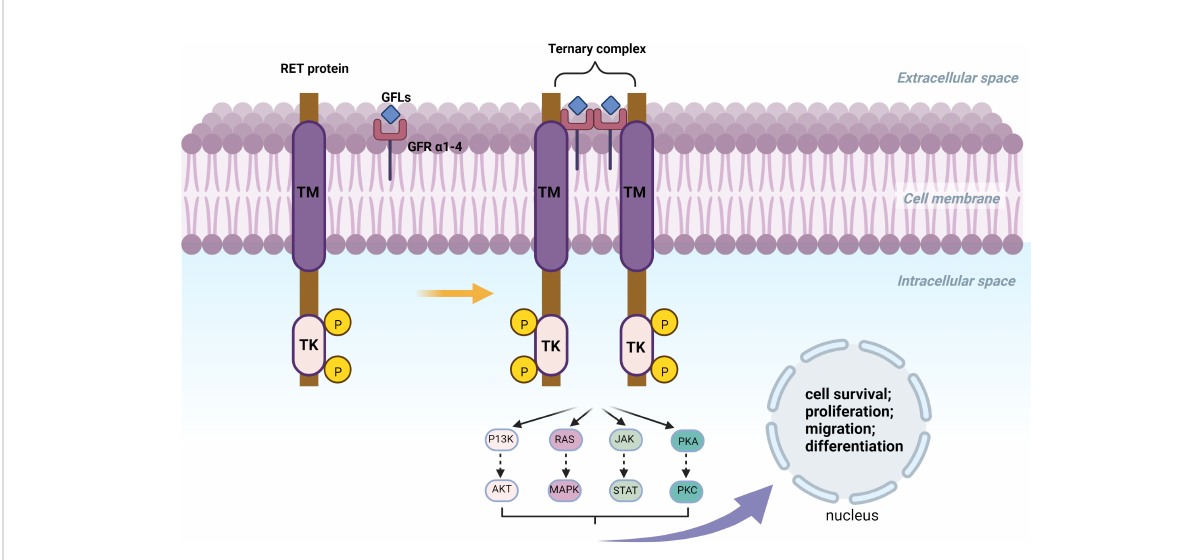
FIGURE 1 TM, Hydrophobic Transmembrane domain; TK, Tyrosine Kinase domian; KM, Kinesin motor; aa, amino acid. The RET gene forms a ternary complex with GFLs and GFR a 1-4. RET fusion can form Ligan-Independent Homodimerzation and further activate or inhibit P13K/AKT, RAS/MAPK, JAK/STAT and PKA/ PKC. Activation or inhibition of these pathways is closely related to cell survival, proliferation, migration and